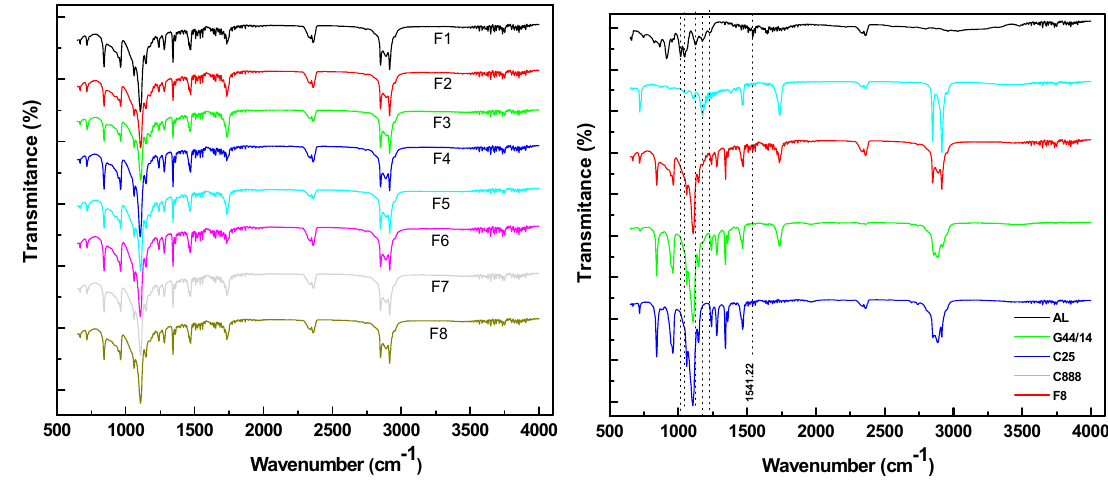
Figure 1. Comparative representation of FTIR spectra recorded for all 8 formulations (left) and FTIR